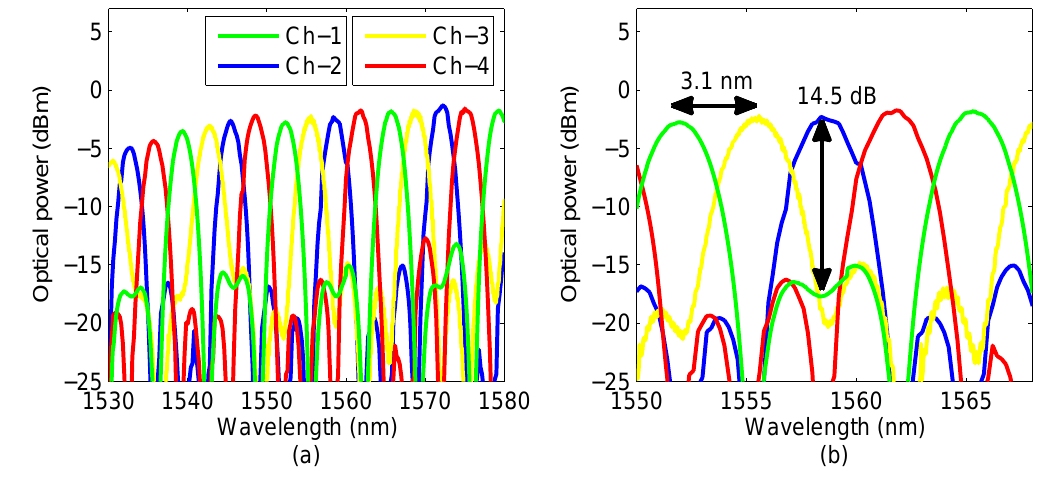
Figure 12. ( a ) Overlapped transmission response of the four optical output channels. ( b ) Zoomed view of the optical response shows 14.5 dB crosstalk for ch-2